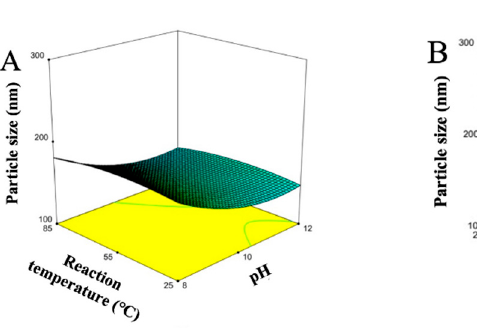
Figure 2. Response surface plots showing the effects of the interaction of ( A ) pH ( X 1 ) and reaction temperature ( X 3 ), ( B ) pH ( X 1 ) and amount of Ch ( X 2 ), and ( C ) amount of Ch ( X 2 ) and reaction temperature ( X 3 ), while keeping the other factor at the zero level (middle level), on the size of Ch-IONPs.